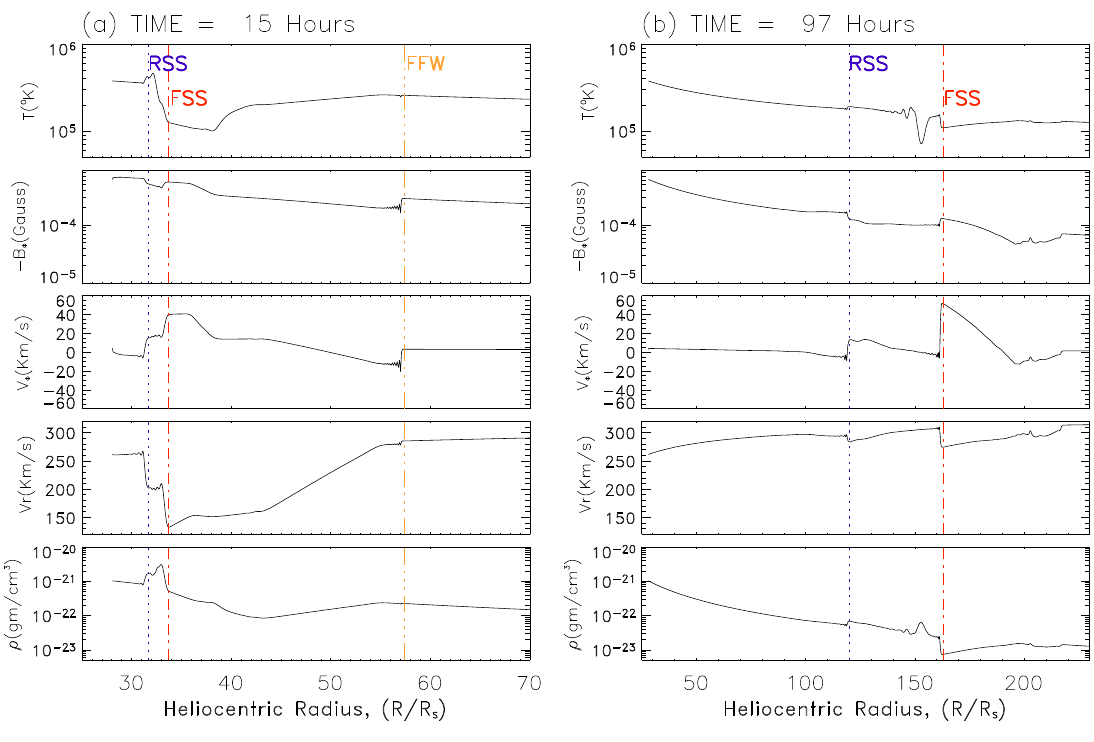
(cid:1)(cid:2) 0 = 0 . 4 , T 0 = 0 . 4. (a) and (b) show the solar wind solution versus r v r ◦ (cid:0) T ◦